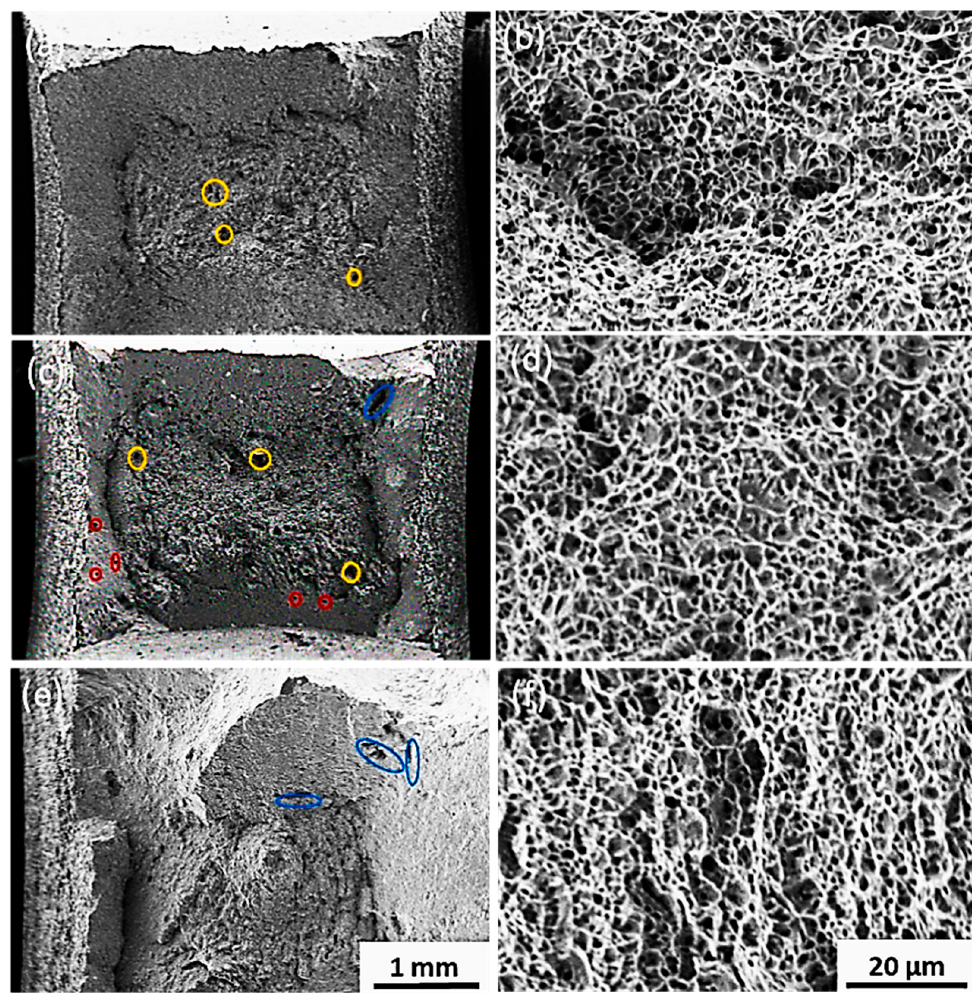
Figure 10. SEM for the WAAM-ed prismatic blocks built at: ( a , b ) 130 (5 mm); ( c , d ) 230 (7 mm); ( e , f ) 330 (9 mm) at a constant OP (30%), respectively. Gas porosity—red circles; microvoids—yellow cir- cles; secondary cracks—blue ovals.